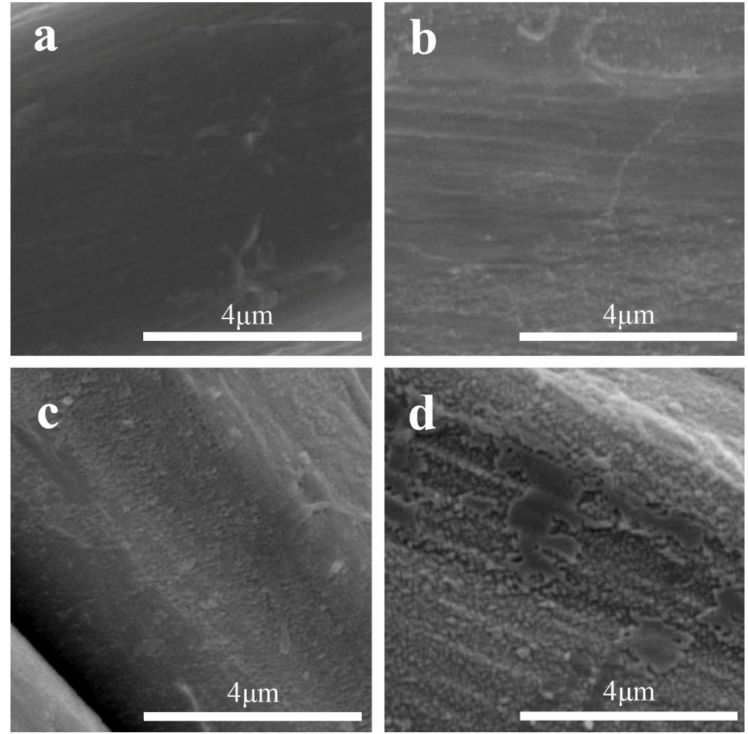
Figure 2. Effect on the surface roughness of the fiber due to increasing time in Ar-plasma treatment of samples: ( a ) NW C-Ar5; ( b ) NW C-Ar10; ( c ) NW C-Ar20; and ( d ) NW C-Ar30. SEM images were taken at 10 kV and ˆ 10,000 magnification.